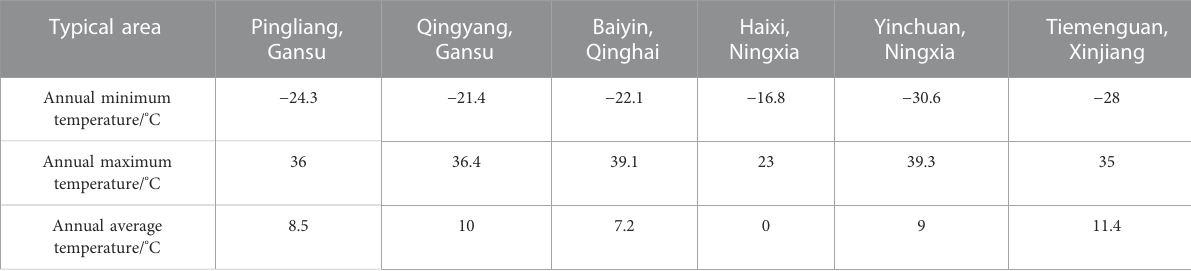
TABLE 4 Typical climate data. Typical